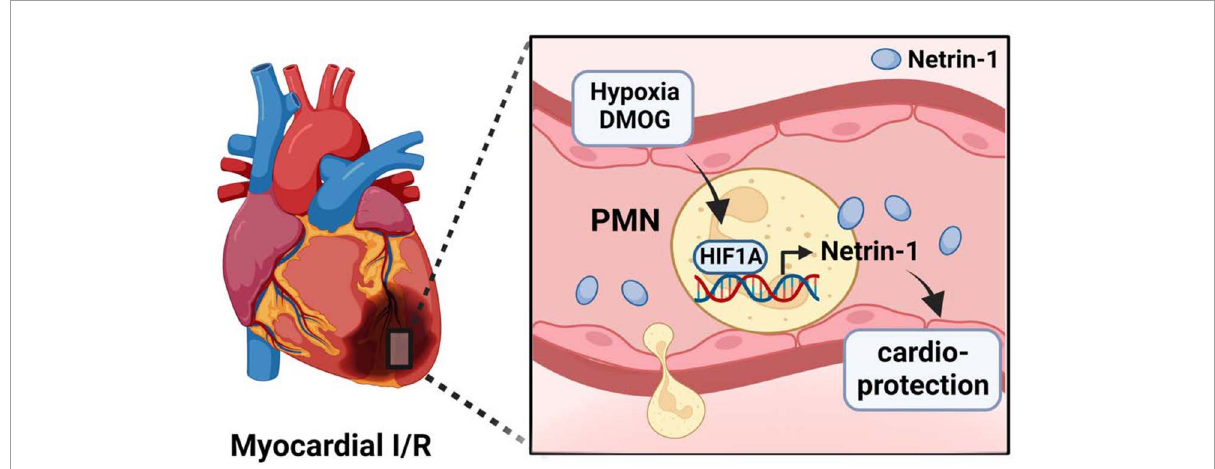
FIGURE7 Suggested mechanism of HIF1A-induced cardioprotection during myocardial ischemia and reperfusion injury. During myocardial ischemia and reperfusion injury, neutrophils undergo hypoxia, leading to stabilization of HIF1A. HIF1A subsequently induces increased expression and release of neuronal guidance proteins Netrin-1 by PMN. Netrin-1 then reduces a reduction in infarct